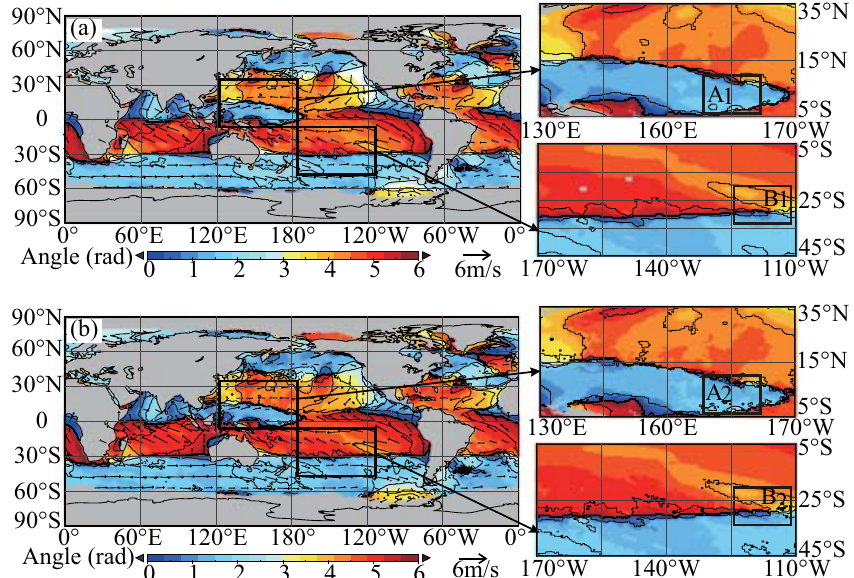
Fig. 2. The direction pattern comparison. (a) is the angle value calculated by optional rotor estimation, and (b) is calculated with the original vector data.